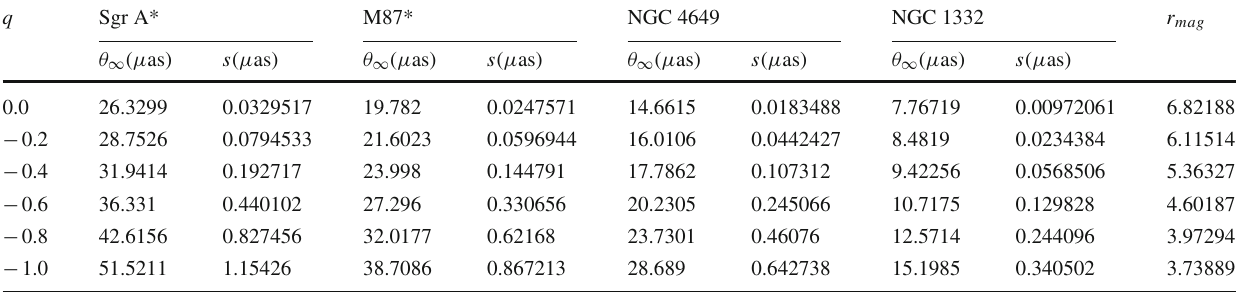
Fig. 7 The behavior of lensing observables θ ∞ (left), s (right) as a function of hair parameter q in strong field limit by considering the supermassive black holes at the centres of nearby galaxies as hairy black holes in Horndeski gravity Table 2 Estimates for the lensing observables of primary images for M87*,NGC4649,andNGC1332aslens.Theobservable r mag doesnot black holes in Horndeski gravity and compared with Schwarzschild depend upon the mass or distance of the black hole from the black ( q = 0 ) in GR considering the supermassive black holes Sgr A*,